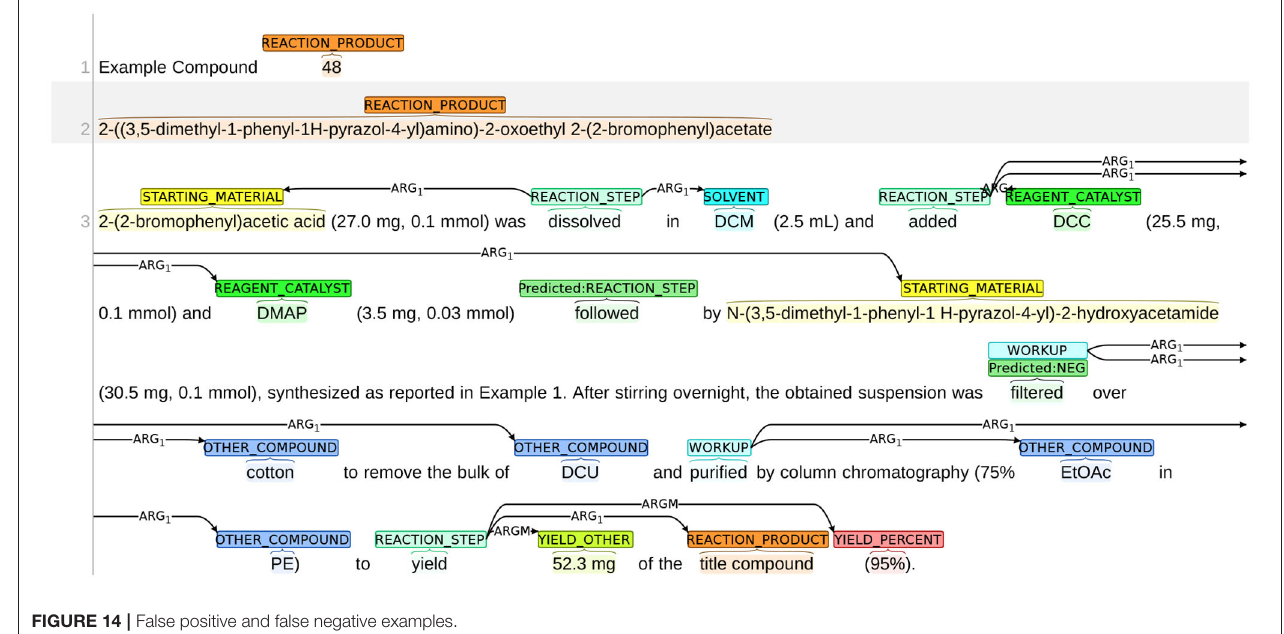
Another example is the entity “aqueous” with entropy of